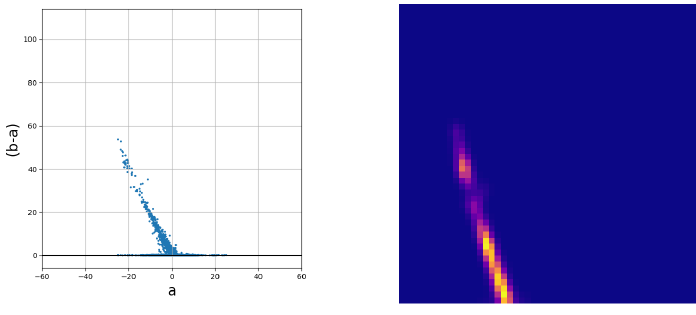
Figure A6. Tense driver with rigid seat.